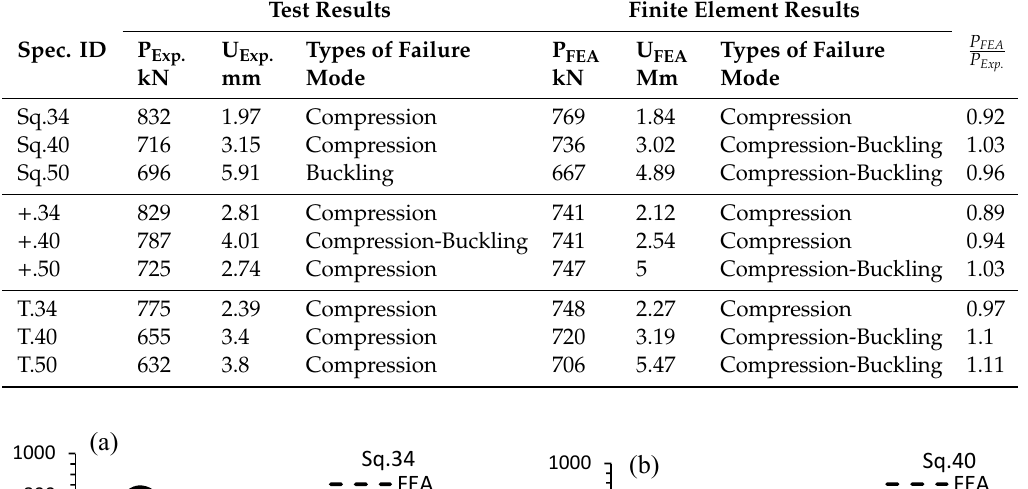
Table 2. Results of the experimental test and finite element analysis.